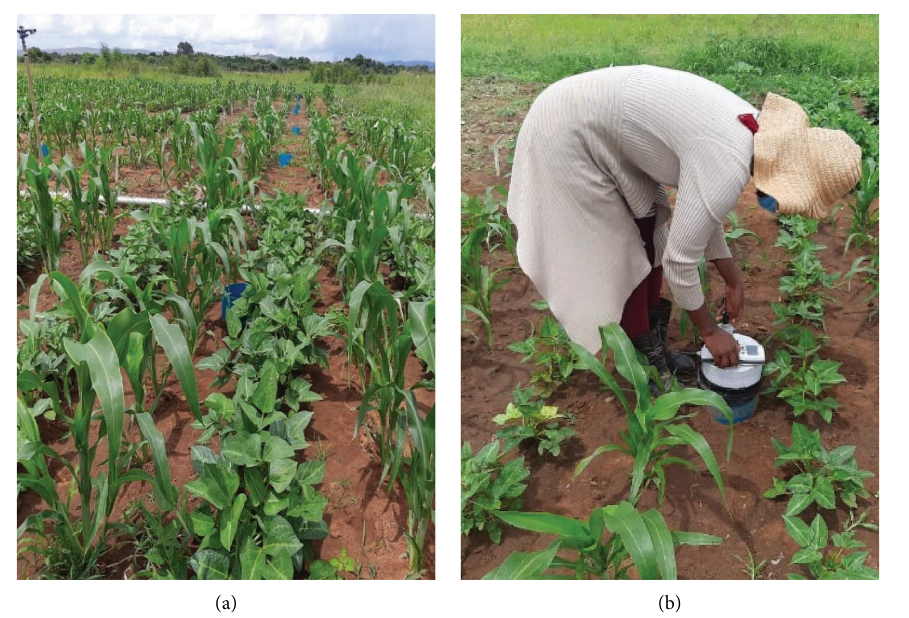
Figure 5: (a) Installed pvc chamber/collar and (b) soil CO